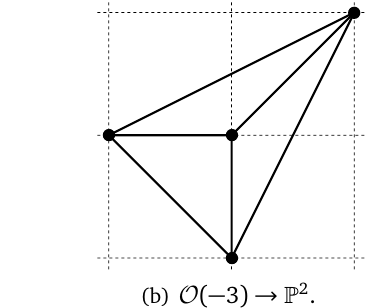
(a) (cid:67) 3 / (cid:90) 3 . Figure 3: Toric diagram for the (cid:67) 3 / (cid:90) singularity, and its crepant resolution. In this 3 = ( − 1,0 ) , w = ( 0, − 1 ) , w = ( 1,1 ) example, there are three external points w 1 2 3 = 3 ) , one internal point w = ( 0,0 ) ( r = 1), and a unique triangulation of the ( n E 0 toric